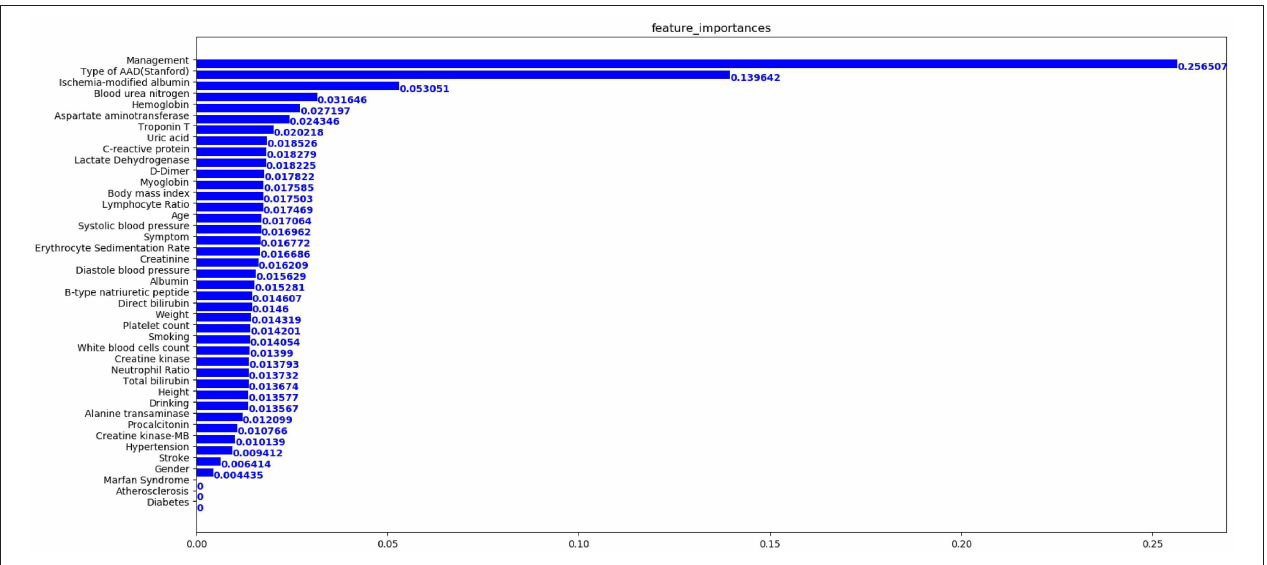
FIGURE 4 | Importance matrix plot of the XGBoost model. The top 20 important features regarding the development of the final predictive model are